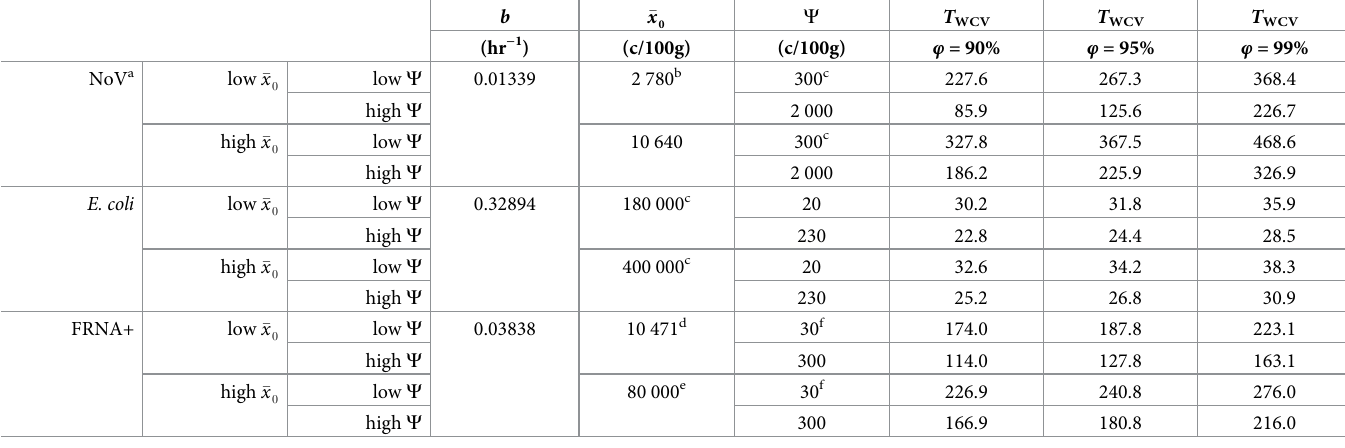
, C for common water-borne pathogens found in 0